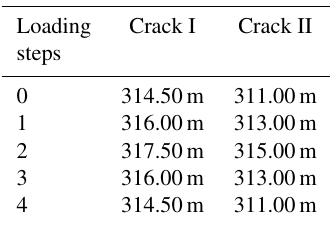
Table 5. Loading steps of the water level in cracks I and II in finite- element